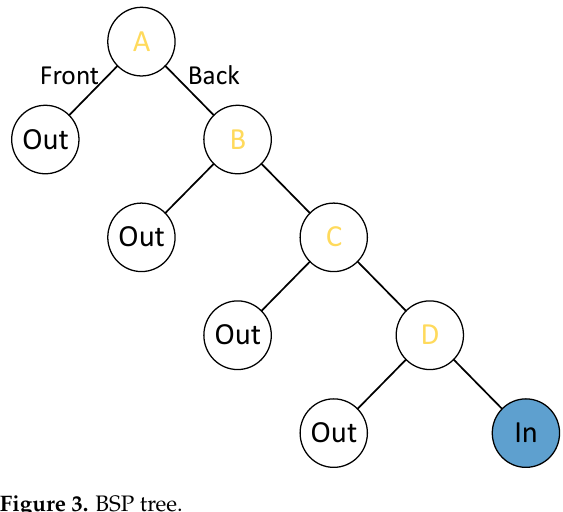
Figure 3. BSP tree.